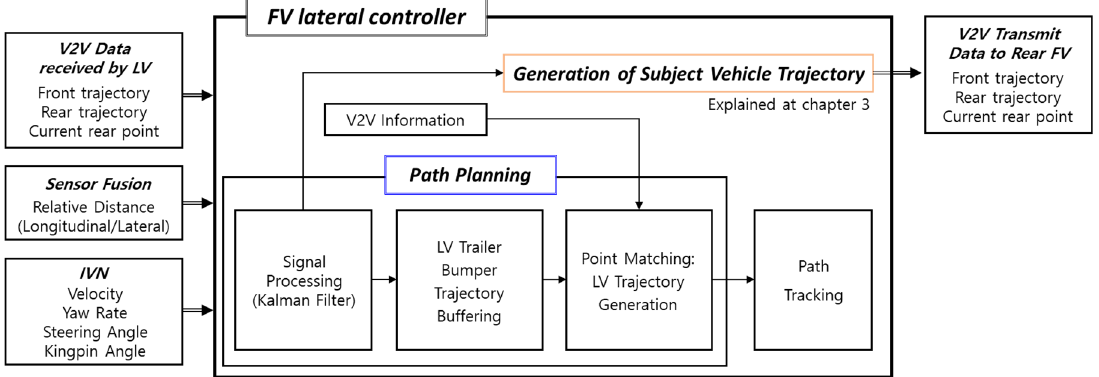
Figure 11. The architecture of the FV lateral controller.